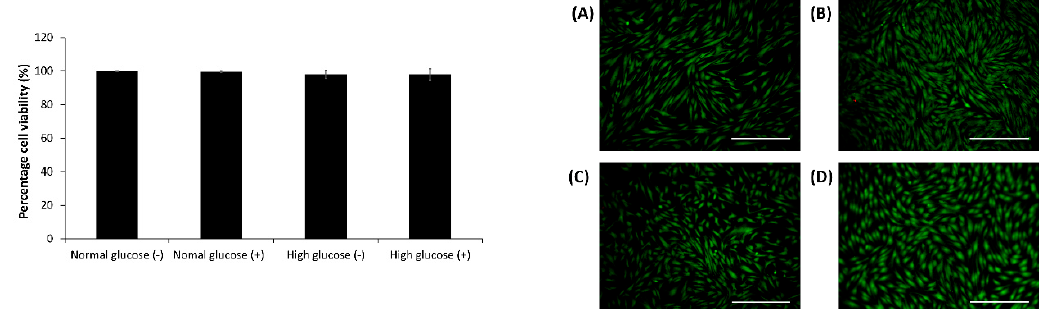
Figure 2. Cell viability detected by calcein AM and ethidium bromide for primary human adult dermal fibroblasts (HDFa) cultured in normal (5.5 mM) glucose condition with and without stimulation, ( A , B ) respectively and high glucose (25 mM) condition without and with stimulation ( C , D ) respectively. Scale bar 500 µm. The results are presented as the mean ± standard deviation for n = 3, * p < 0.05.